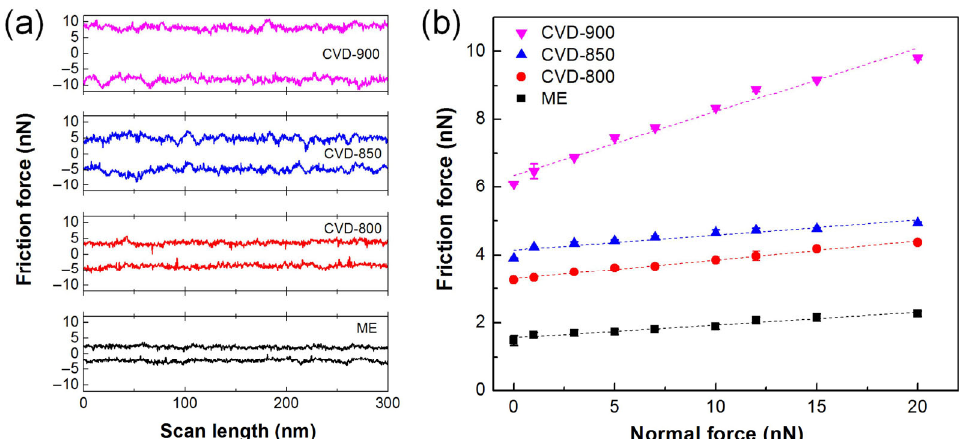
Fig. 4 (a) Examples of friction loops and (b) variations in friction force of the mechanically exfoliated single-layer MoS 2 and CVD-grown single-layer MoS 2 at 800 ° C, 850 ° C, and 900 ° C with respect to the normal force. In (a), the friction loops were obtained under 10 nN normal force. In (b), the dashed lines indicate the linear curve fits and the error bar represents one standard